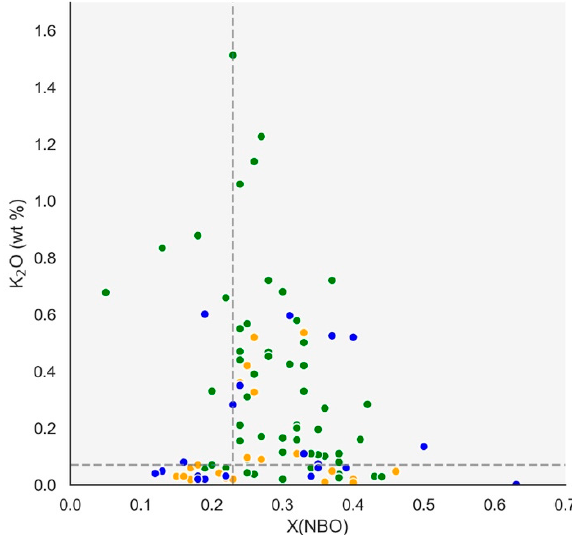
Figure 3. Plot comparing X(NBO) and K 2 O (wt%) for 100 impact glasses sizes of ≥ 200 μ m with ‘good’ (green), ‘fair’ (yellow), and ‘poor’ (blue) age assessments (as defined in the text). K 2 O (wt%) = 0.07 and X(NBO) = 0.23 are indicated by the dashed lines. Data are from [6–10] and Table 1.